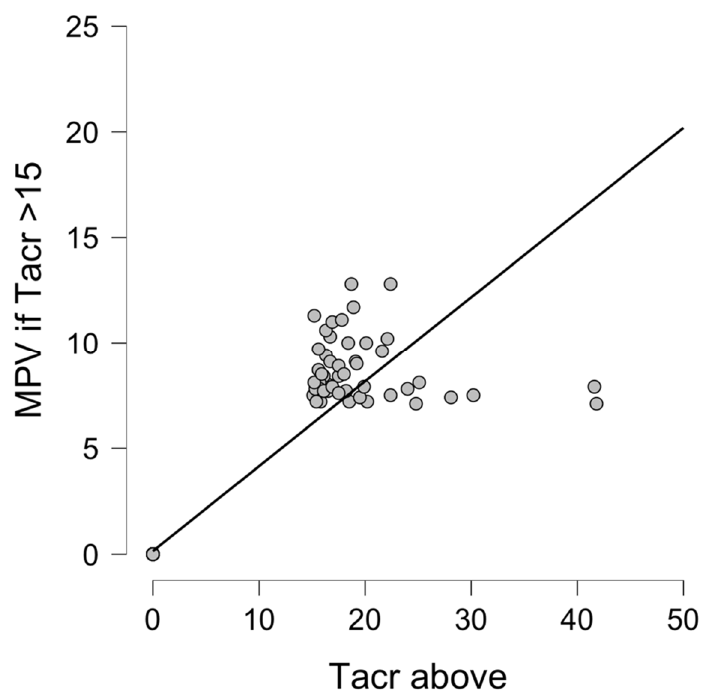
Figure 2. Correlation between MPV and Tacrolimus overdose (Tacr serum level > 15 ng/mL). Abbreviations: MPV—mean platelet volume, Tacr—tacrolimus.